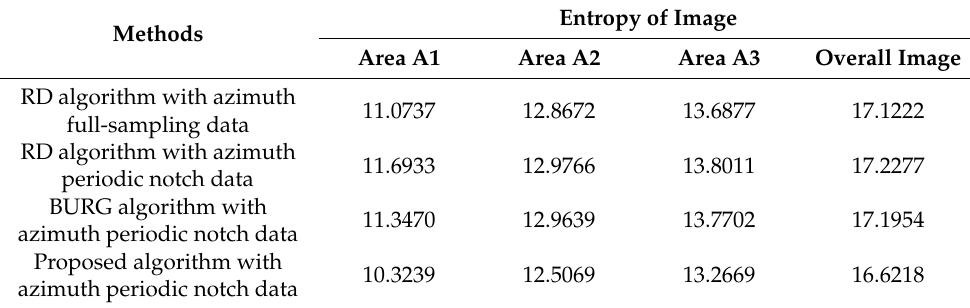
Table 3. Comparison of image entropy.